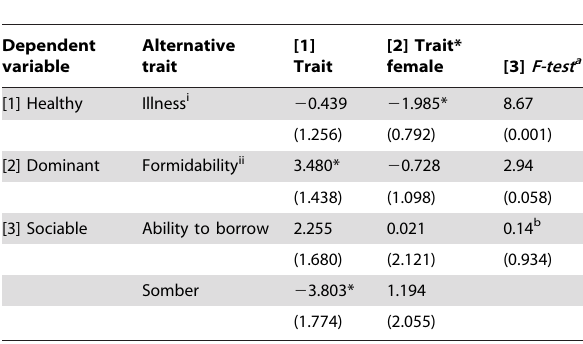
Table 4. Robustness analysis of the results using other measures of traits.